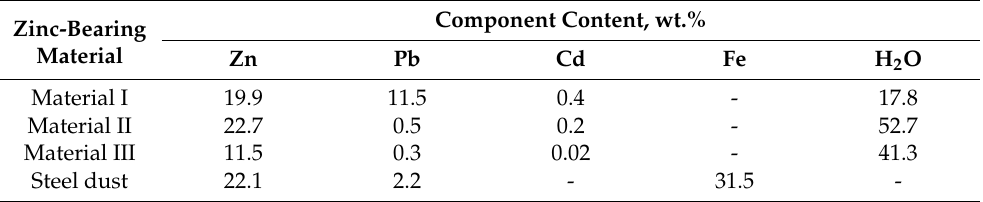
Table 2. Summary of the basic chemical composition of materials used in the research.